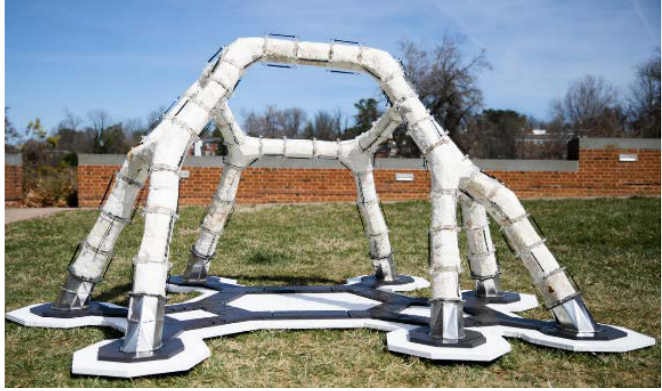
Figure 16 MycoCreate 2.0.-2022 (Url-21).